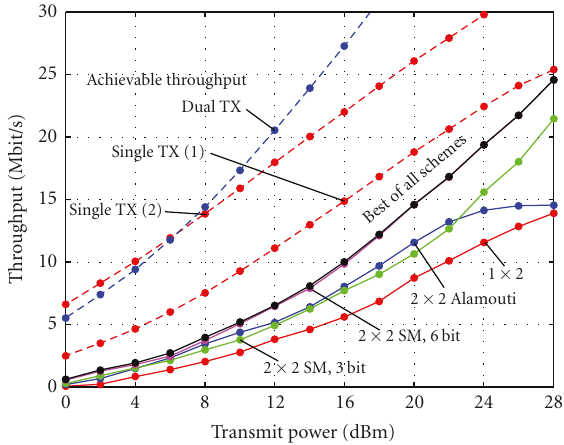
Figure 9: Scenario 2, measured (solid) and achievable (dashed) data throughput in the NLOS outdoor-to-outdoor scenario using two receive antennas. The largest transmit power corresponds to a receive SNR of about 24